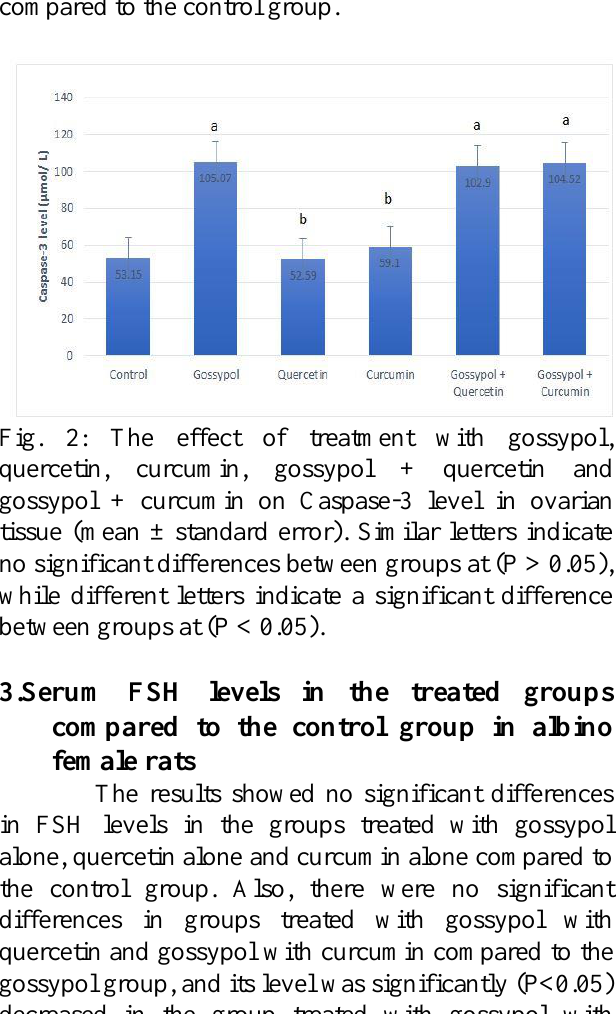
indicate no significant differences in AMH levels in groups treated with gossypol alone and quercetin alone compared with the control group. In contrast, there was a significant (P<0.05) increase in AMH level in the group treated with curcumin compared to the control group.